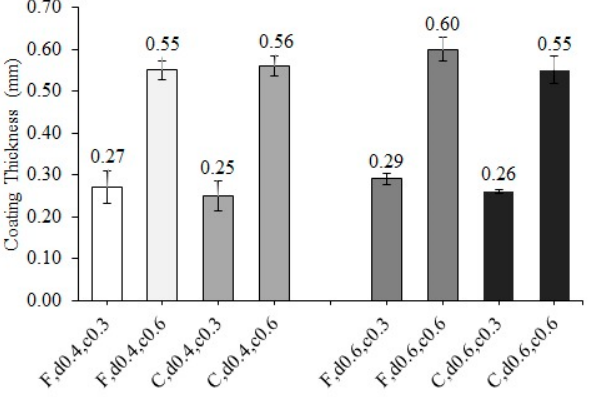
Figure 3. The final coating thickness of 0.3 mm and 0.6 mm at various particle geometry and board density of particle board.